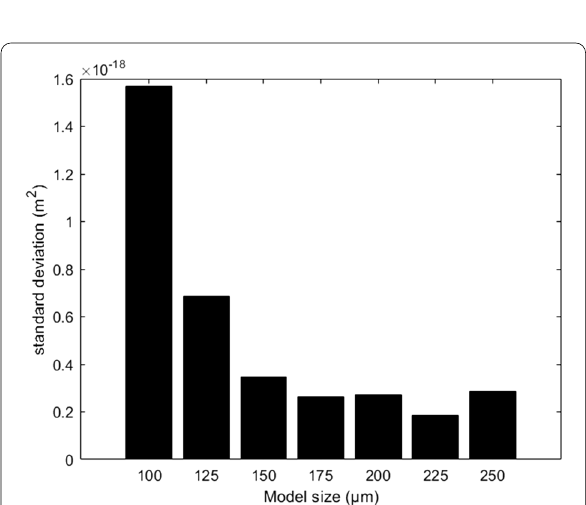
Fig. 16 Influence of model size on standard deviation of permeability